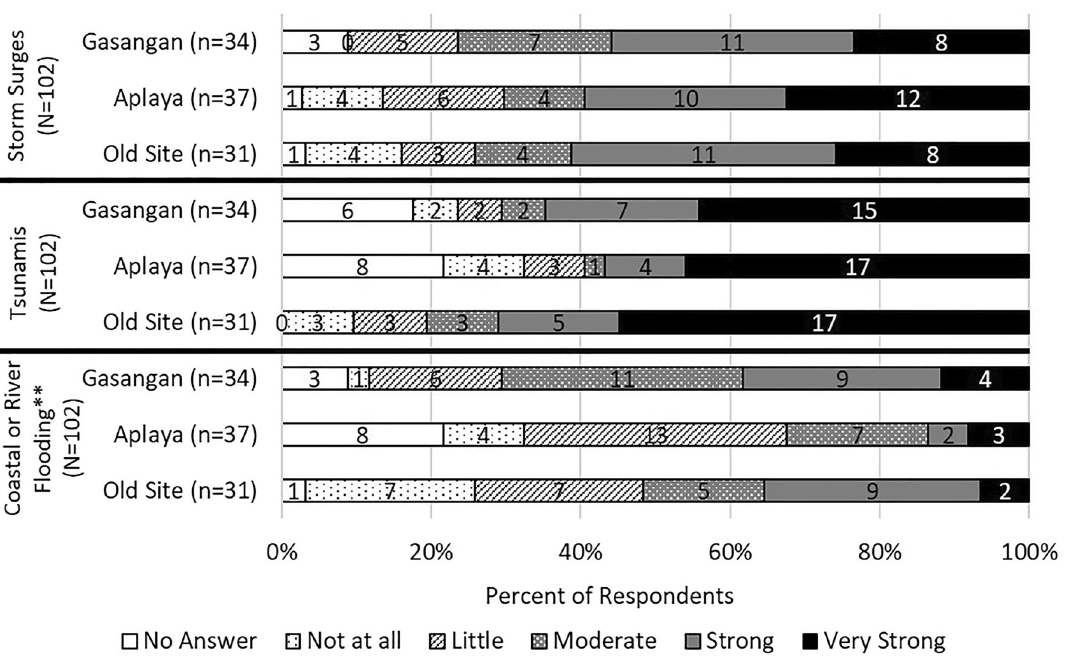
Fig. 4 Perception of danger of coastal hazards according to location (** P \ 0.05) in BASECO Compound in